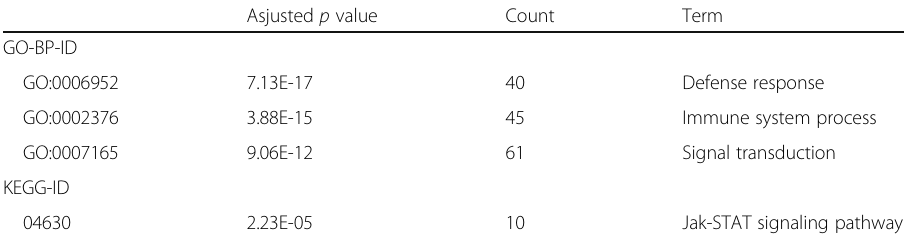
Table 2 Significant GO biological processes and KEGG pathways for common DEGs in all three comparisons Asjusted p